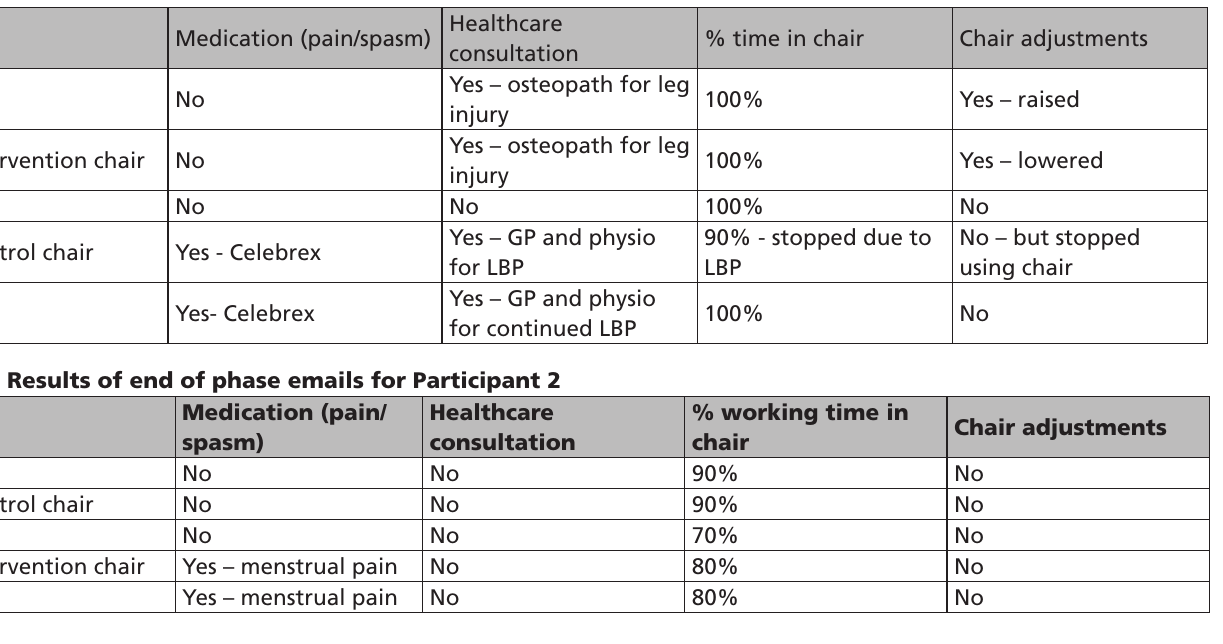
Table 4: Results of the end of phase emails for Participant 1